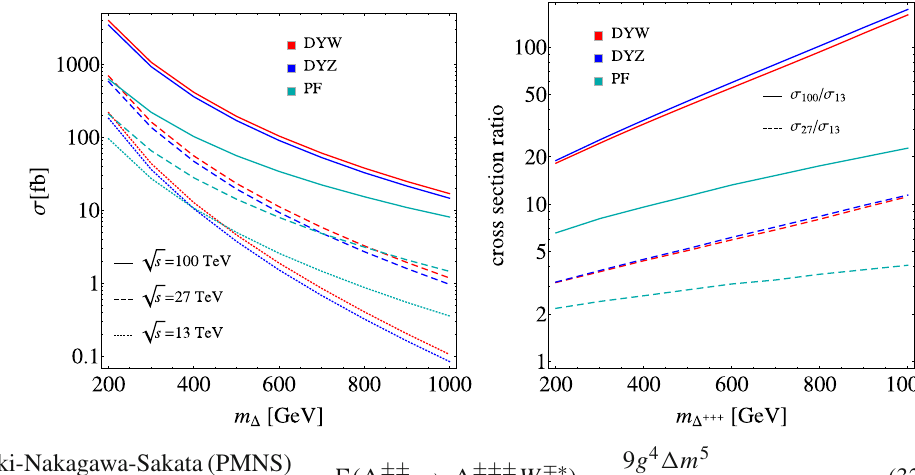
Fig. 3 Left: Production cross sections of triply charged Higgs bosons via the Drell-Yan processes (DYW, DYZ) and photon fusion process (PF) at √ s = 13, 27 and 100 TeV as a function of m (cid:2) ±±± with the mass splitting neglected. Right: ratios of cross sections at √ s = 27 and 100 TeV to that at √ s = 13 TeV, denoted as σ /σ σ /σ 27 13 and 100 13 , respectively